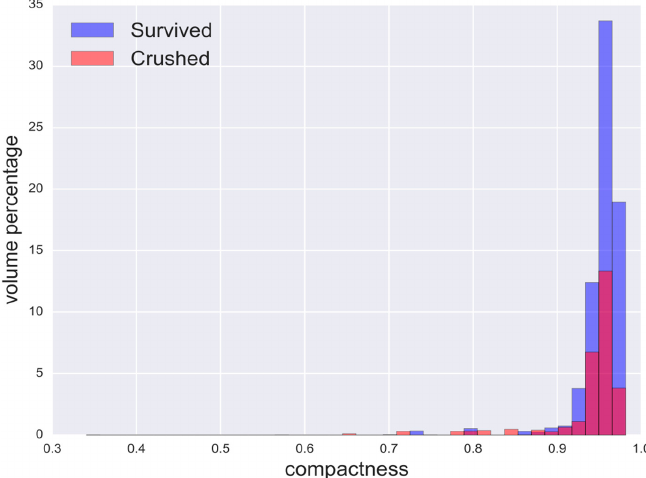
Figure 17. Volume-weighted histograms of intragranular porosity for crushed and survived particles.